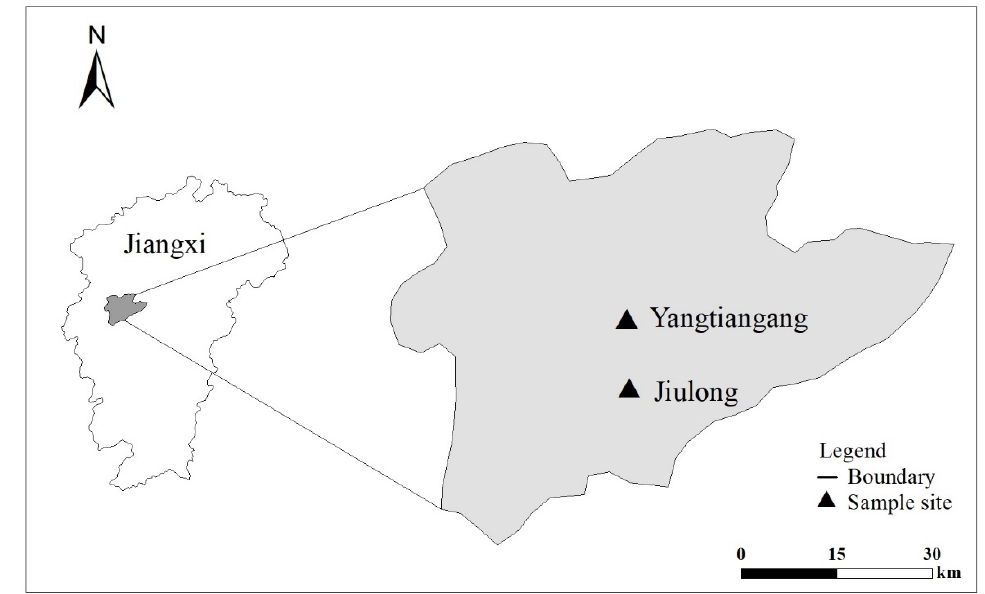
Figure 1. Location map and different sampling sites of investigated tailing